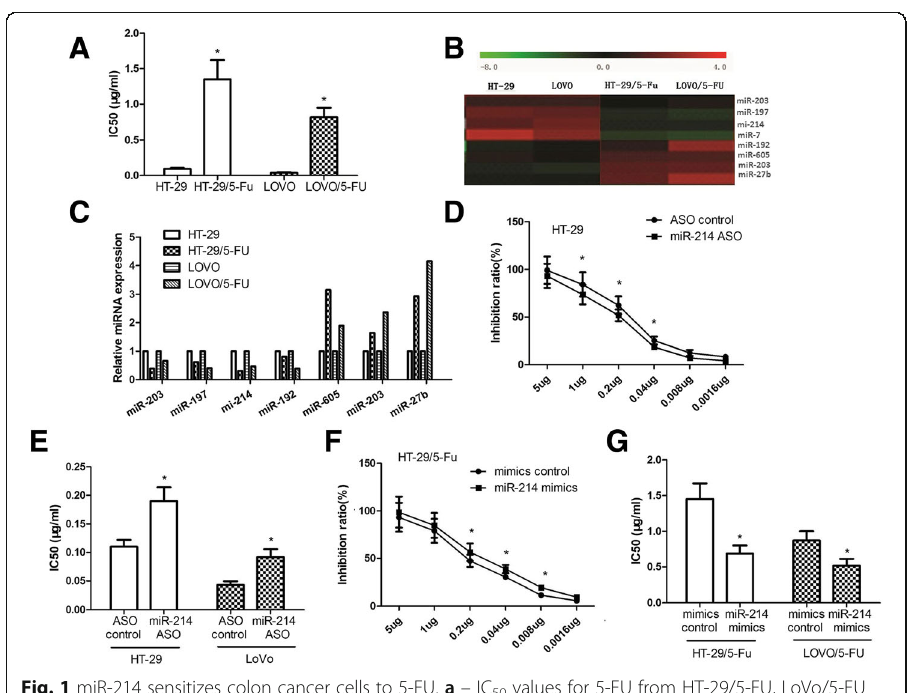
profiles from HT-29, HT-29/5-FU, LoVo and LoVo/5-FU cells determined using microarray assays. c – Quantification of miRNA expression inHT-29, HT-29/5-FU, LoVo and LoVo/5-FU cells was performed via qPCR to validate the results of the microarrays. d and e – HT-29 and LoVo cells were both transfected with miR-214 ASO and control. After incubation with 5-FU at concentrations of 0.0016, 0.008, 0.04, 0.2 and 1.5 μ g/ml for 48h, inhibitions were detected using CCK-8 assays, and the IC 50 values were determined. F and G – HT-29/5-FU and LoVo/5-FU cells were both transfected with miR-214 mimics and controls. Inhibitions ( f ) and IC 50 values ( g ) were determined as in d and e . Data represent the means ± SEM of three independent experiments. * p<